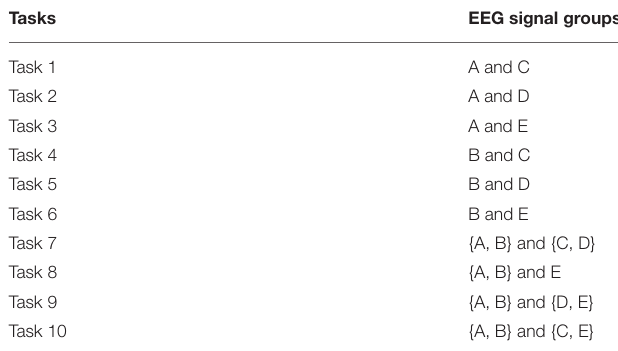
TABLE 2 | Ten EEG classification